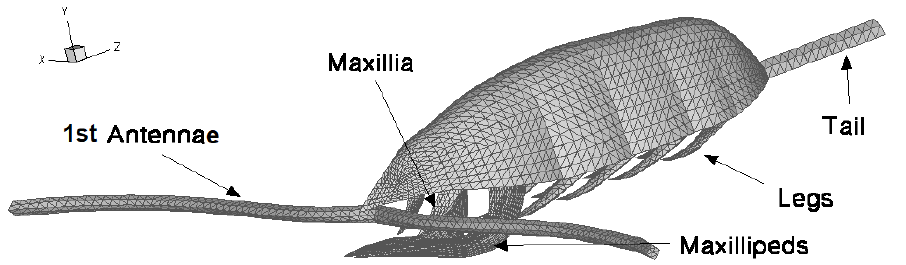
Figure 1. A typical calanoid copepod with all the appendages modeled in computer aided design (CAD) and meshed with triangular elements for numerical simulations. Reproduced with permission from